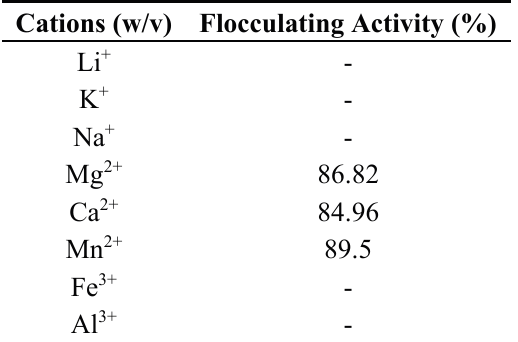
Table 1. Effect of cations on the flocculating activity of crude REG-6 produced by Bacillus toyonensis strain